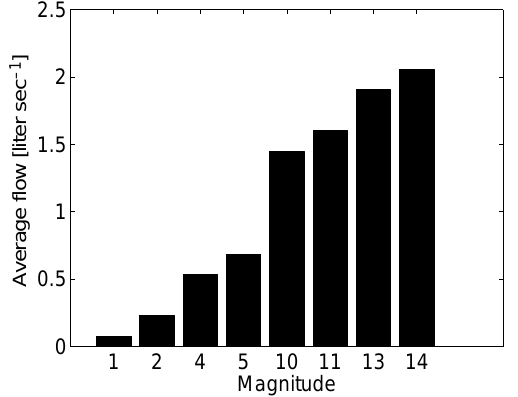
Figure 8. Average flows at different locations along the Mandelbrot–Vicsek